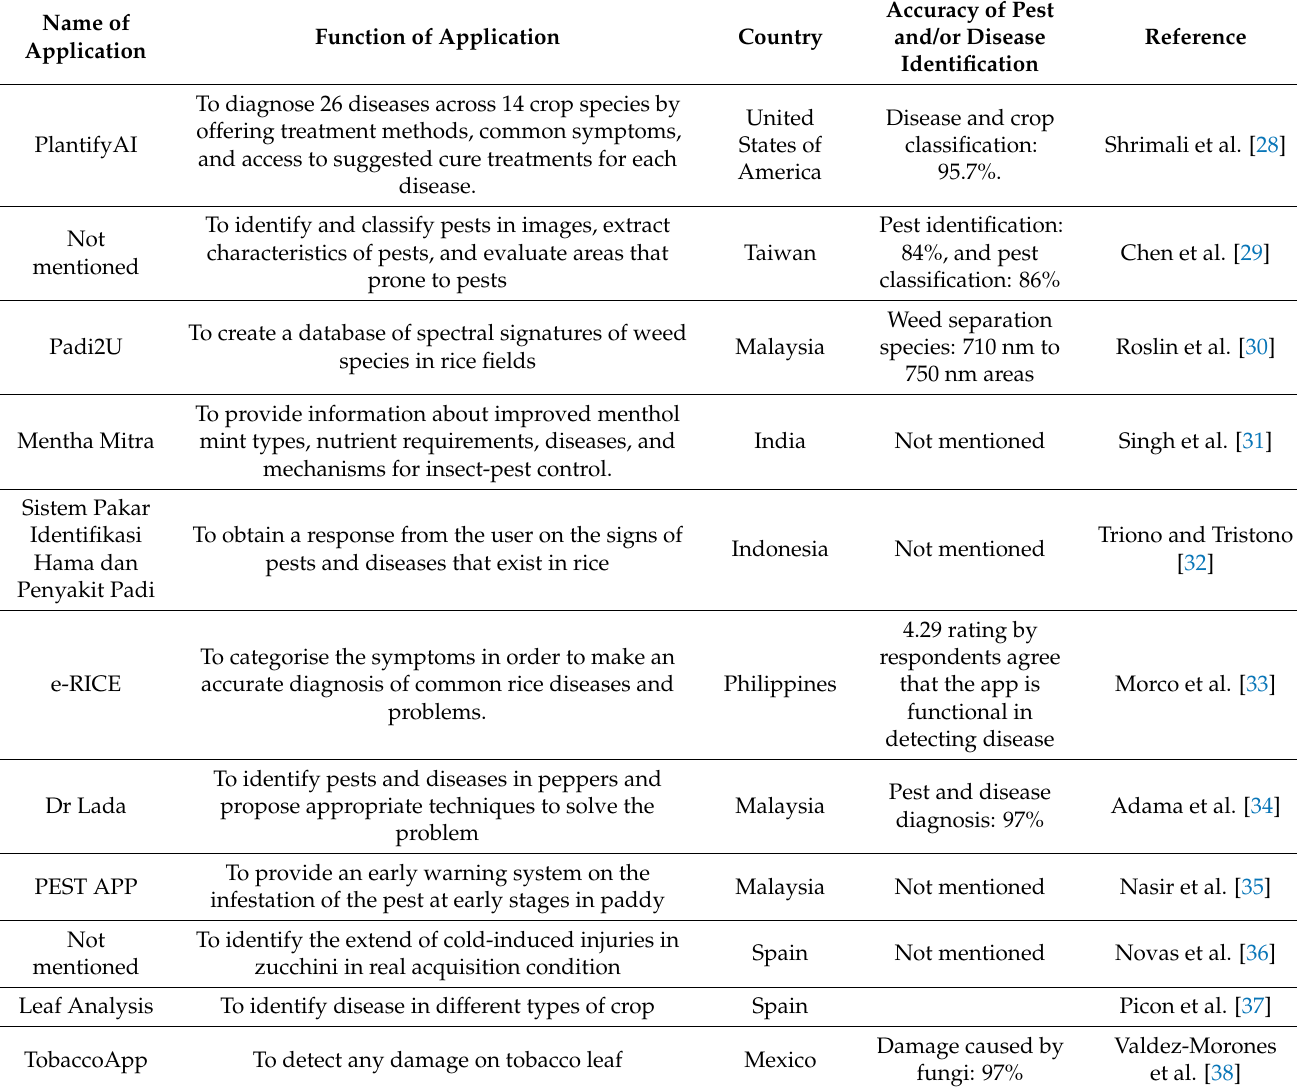
Table 1. List of mobile applications and their function in pest and disease